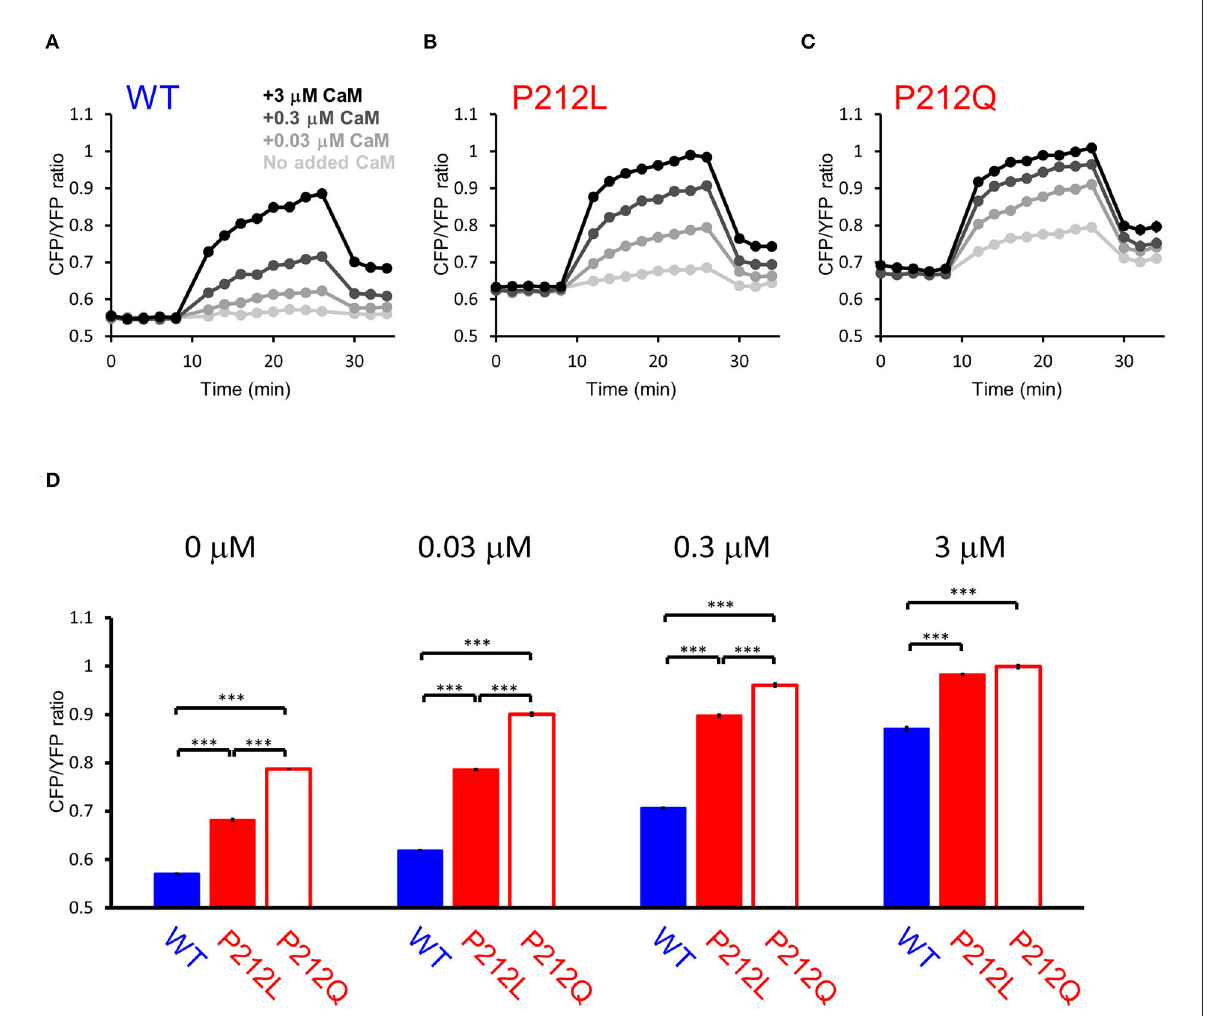
FIGURE6 FRET plate reader analysis revealed quantitative differences in Ca 2 + /CaM-dependent activation between WT, P212L and P212Q. Plate reader FRET assay for WT (A) , P212L (B) , P212Q (C) , and their CaM dose responses (D) under 0, 0.03, 0.3, 3 µ M added CaM. Mean ± s.e.m., two-way ANOVA followed by Turkey’s test. *** p < 0.001. n = 18 for each plot, except for P212L under 3 µ M CaM ( n = 17), in which one measurement showed no response, which was considered to be a procedural error of Ca 2 + addition and excluded.